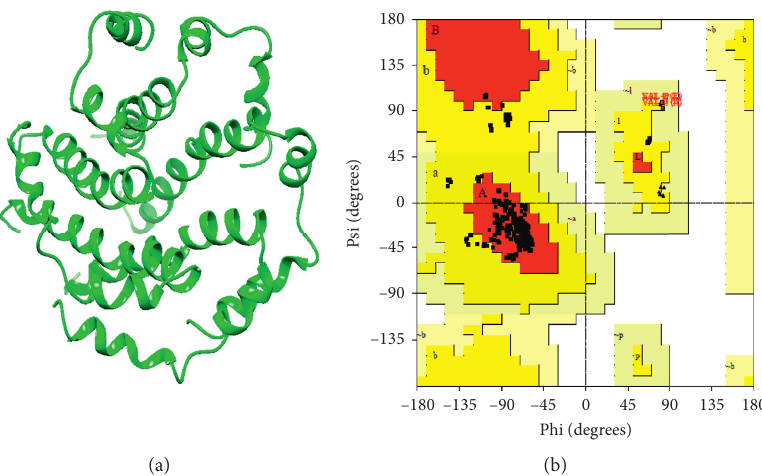
Figure 2: (a) Predicted 3D structure of putative E protein by SWISS-MODEL. (b) Validation of 3D structure of E protein by Ramachandran plot. Table 1: List of conformational B-cell epitopes of the E protein of SARS-CoV-2. No.